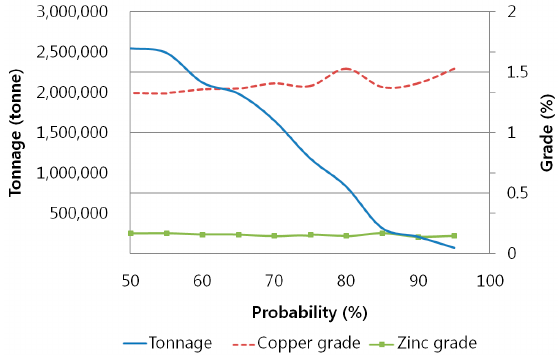
Figure 11. Probability-tonnage-grade graph for ore reserve estimation.